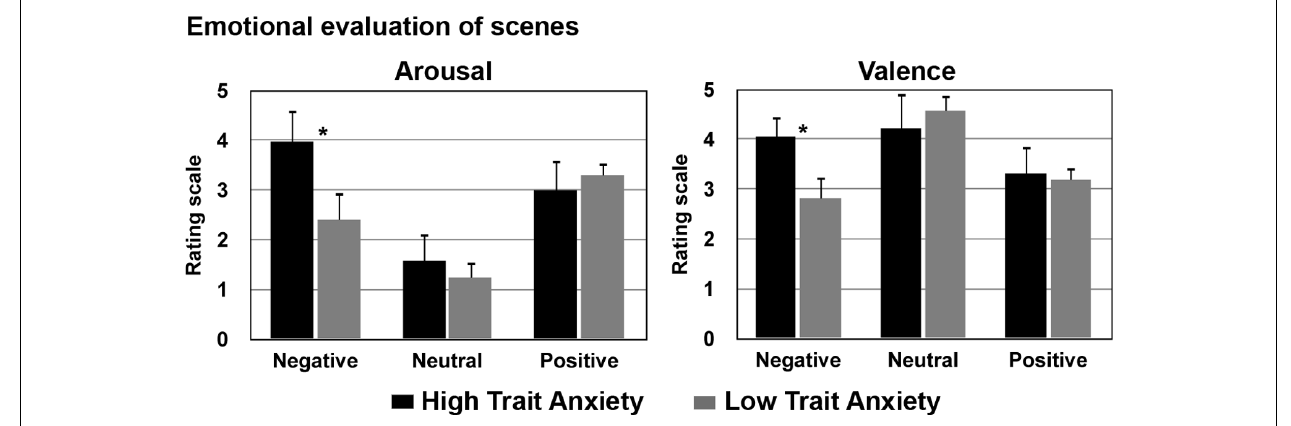
FIGURE 4 | Emotional rating of the presented scenes (on a 5-point scale: from not at all to very much). Left panel: evaluation of arousal (how much was the scene considered arousing) for both groups; right panel: evaluation of valence: how much the presented scene was negative, positive, or neutral for low and high trait anxiety individuals (* p <